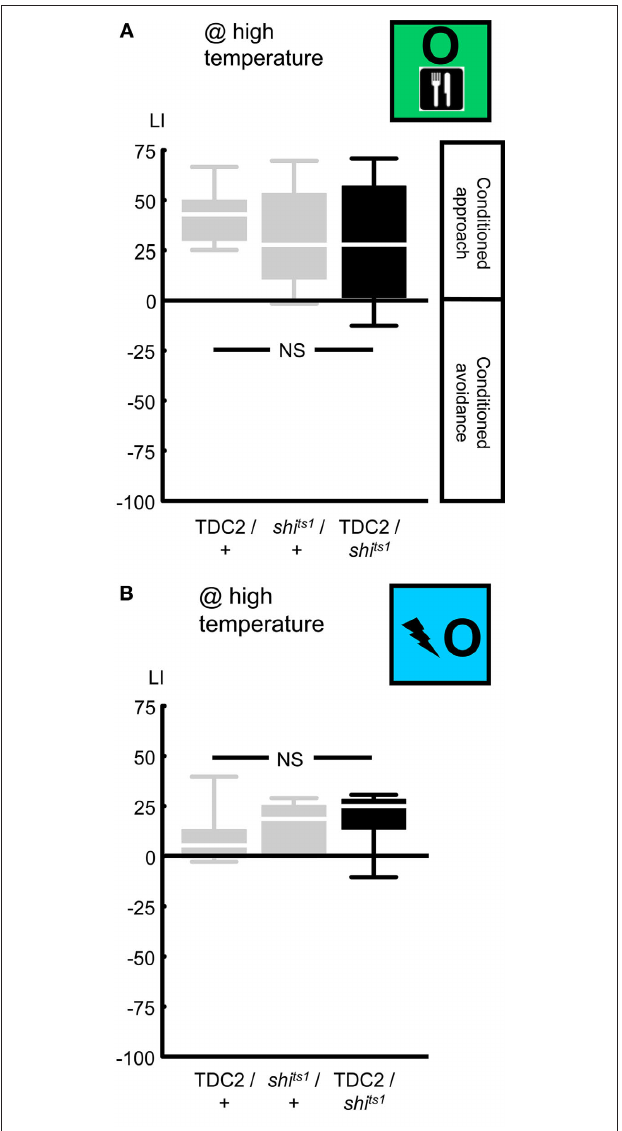
FiGuRe 7 | Targeting a set of octopaminergic/tyraminergic neurons, using the TDC2-Gal4 driver. We expressed shibire ts1 in the set of octopaminergic/tyraminergic neurons defined by the TDC2-Gal4 driver. At high temperature, neither reward learning (A) nor relief learning (B) was impaired. NS: P > 0.05, while comparing between genotypes. Sample sizes were from left to right N = 24, 27, 27 in (A) and 11, each in (B) . Box plots are as detailed in Figure